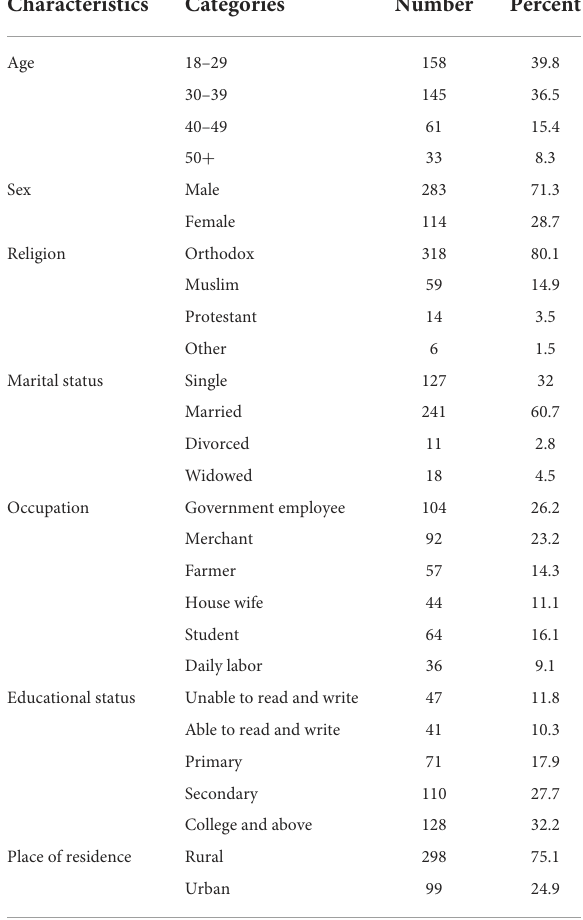
TABLE 1 Socio-demographic characteristics of study participants attending emergency outpatient department of DTCH, Debre Tabor, Ethiopia ( n =